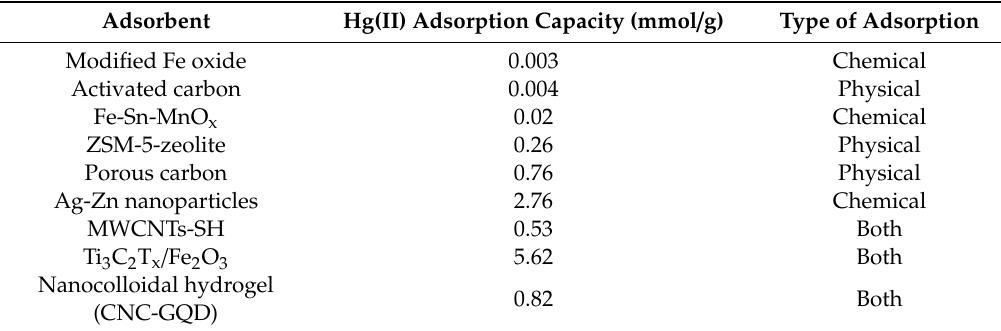
Table 5. Selected adsorbents for Hg(II) and their related adsorption mechanisms.